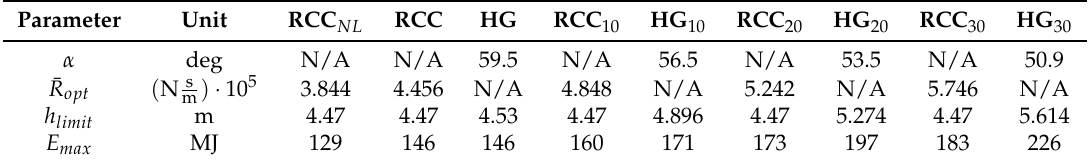
Table 2. Single frequency numerical results.